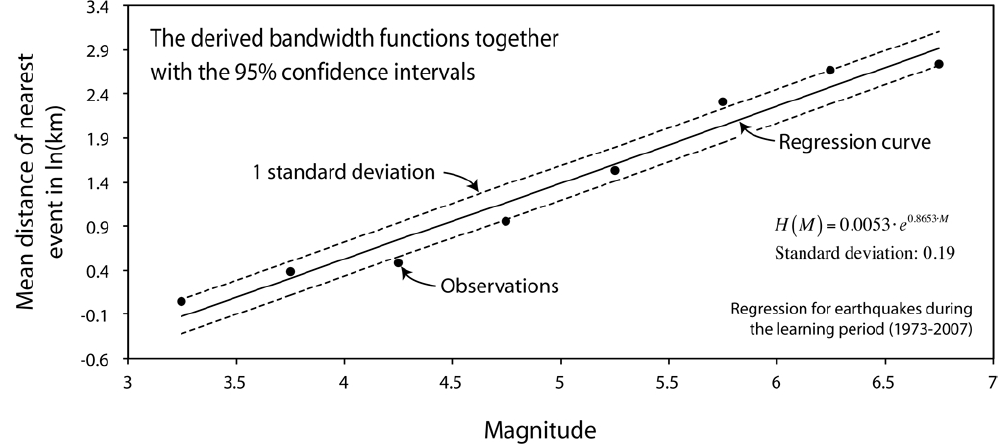
Fig. 5. Bandwidth functions within the 95% confidence interval for the study area using the linear regression of earthquakes that occurred following catalogue completeness by considering the time and magnitude. Note that the mean distance of the nearest event is scaled in